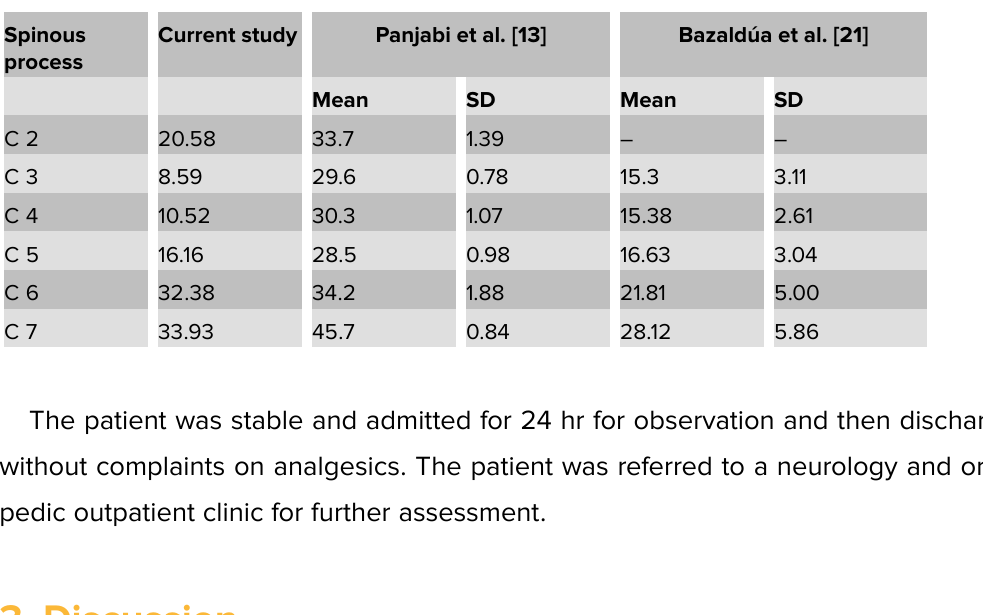
Figure 2 : The 3D construct CT scan of the cervical spine. (2A) Right lateral view; (2B) Left lateral view; (2C) Posterior view. The spinous processes are short and have no bifid end. Table 1: The comparison of the length of the cervical